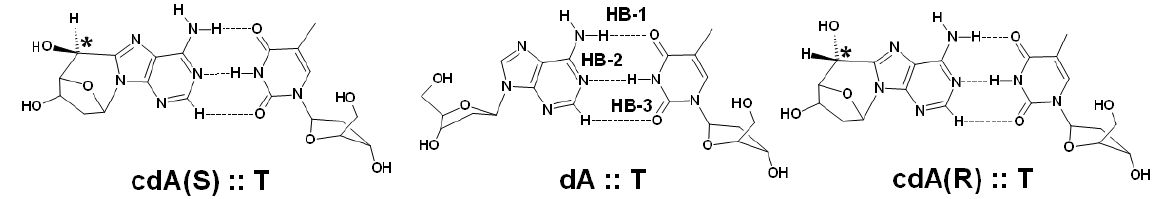
Figure 1. Graphical representation of cdA(R)::T , cdA(S)::T and dA::T nucleosides